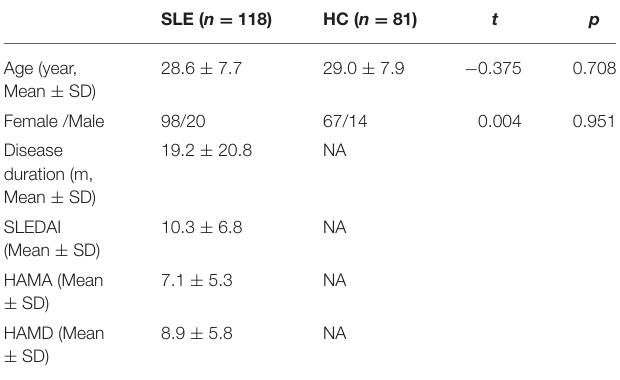
TABLE 1 | Demographic and clinical characteristics of SLE and HC